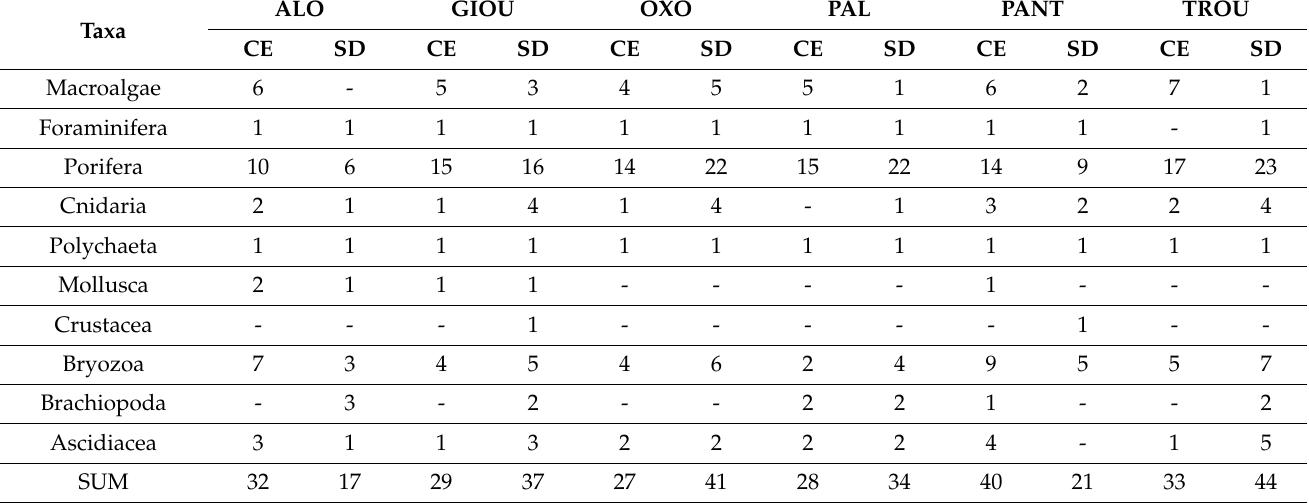
Table 3. Summary data with the total number of taxa by sessile group for each ecological cave zone. ALO: Alona, GIOU: Giourious, OXO: Oxonisos, PAL: Palatia, PANT: Panteleimonas, TROU: Troulakas, CE: entrance zone, SD: semi-dark zone.